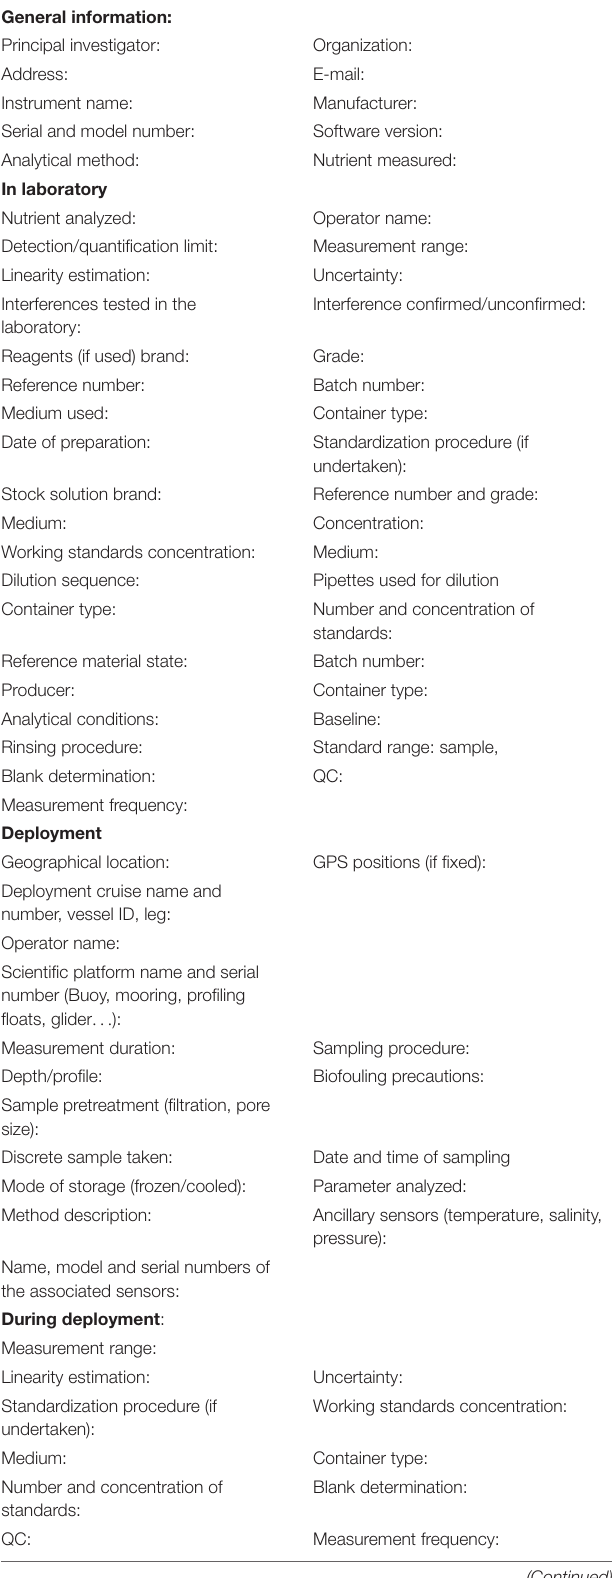
TABLE 8 | Example of form to report metadata of in situ nutrient